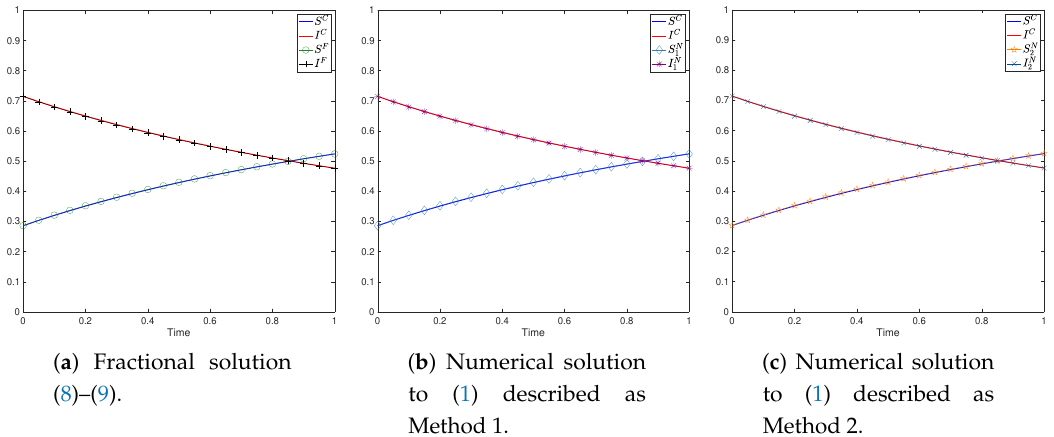
Figure 4. Comparison between the solutions to the SIS model and the fractional solutions to (1) with α = 0.99 (continuity w.r. to α ).